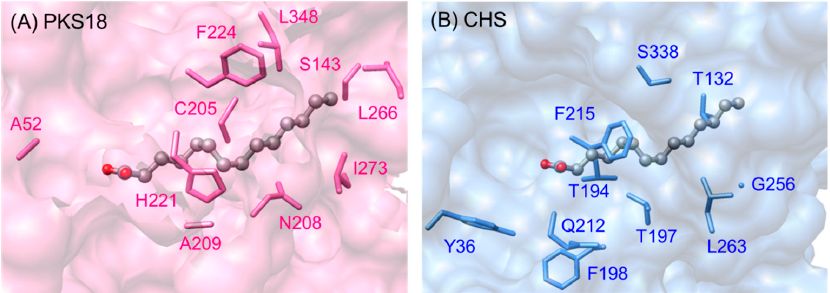
Figure 12. ( A ) Acyl-binding tunnel in M. tuberculosis PKS18 (PDB ID: 1TED); ( B ) Myristic acid